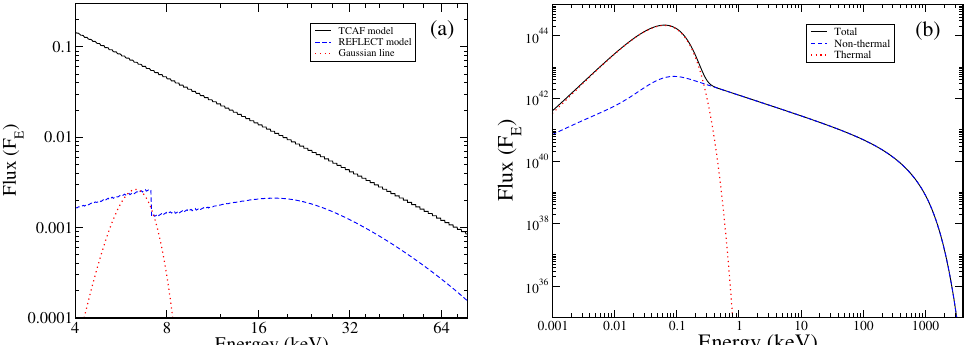
Figure 6. ( a ) Unabsorbed spectra of model components of the fitted spectrum shown in Figure 5d for the NuSTAR OBSID 80502304002 (MJD = 58,655.60) from XSPEC, where the contributions of the TCAF model (black solid curve), REFLECT model (blue dashed curve) and the Gaussian line (red dotted curve) are shown separately. ( b ) Unabsorbed theoretical TCAF model raw spectrum with its two components, generated from the TCAF code using best-fitted TCAF model parameters of the same spectrum. Flux ( F E ) is plotted in photons cm − 2 s − 1 keV − 1